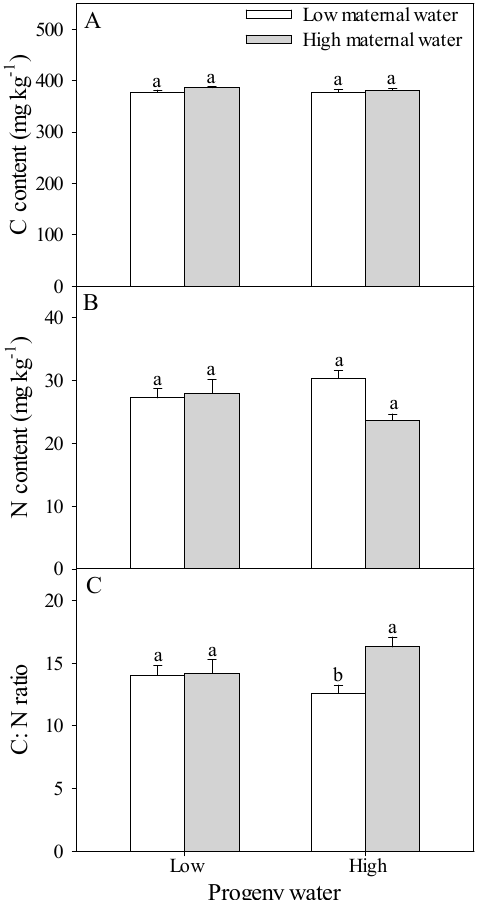
Figure 2. Effects of maternal and progeny water treatments on ( A ) C content, ( B ) N content, and ( C ) C:N ratio. Different lowercase letters represent significantly different means between plants with different maternal water treatments under the same progeny water treatment according to t -test ( p < 0.05).